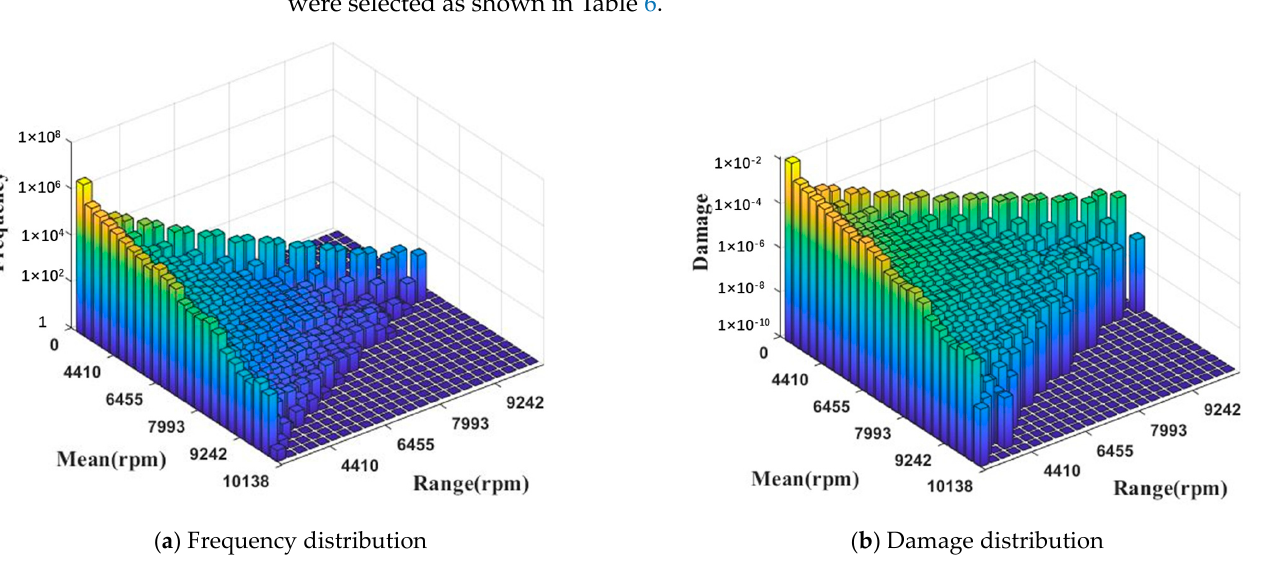
Figure 27. Rotation range—mean frequency and damage distribution. Table 6. Typical operating conditions for variable amplitude fatigue failure mode of motor rotor.